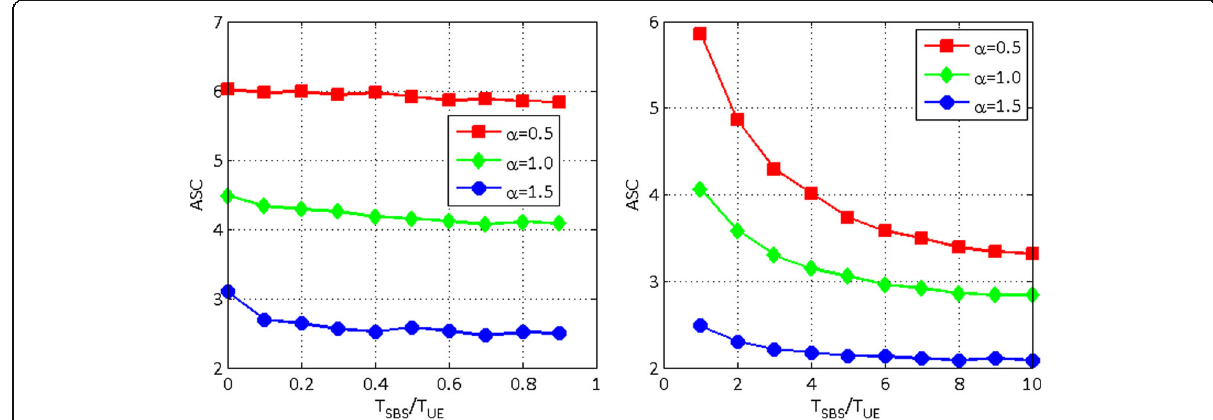
(cid:3) T UE to ASC with different Zipf parameter (